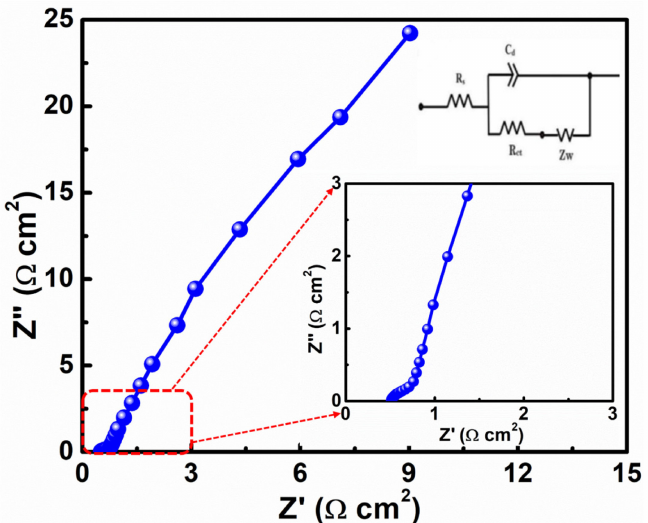
Figure 4. Nyquist plot of CuMn 2 O 4 NSAs electrode (inset shows the enlarged Nyquist plot and equivalent circuit to fit the Nyquist